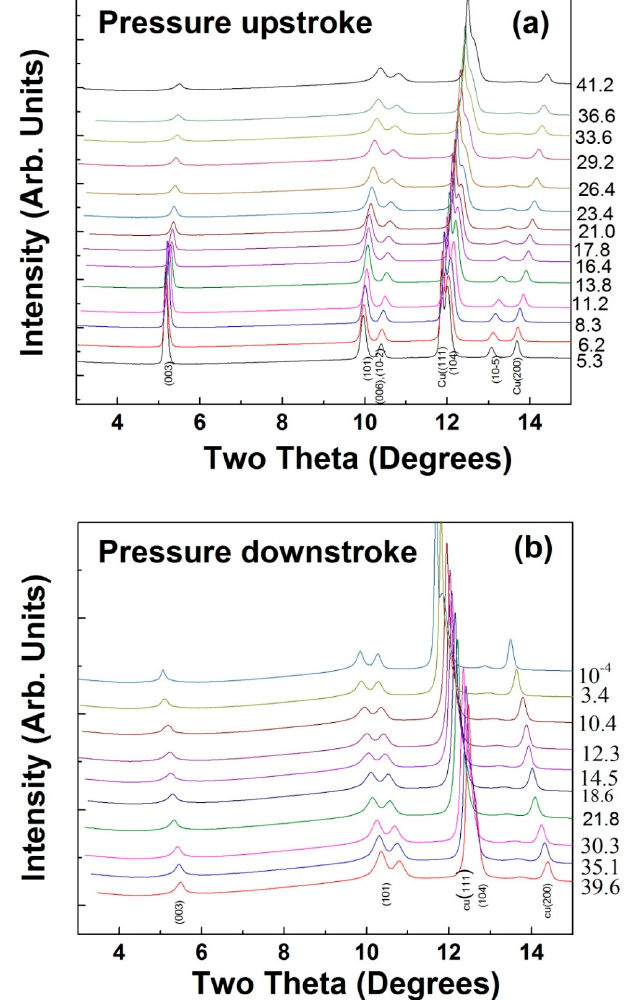
Figure 5. ( a ) Evolution of X-ray diffraction patterns for LiCrO 2 while compressing; ( b ) while decompressing. Diffraction peaks from in-situ pressure calibrant (Cu) are also indicated. Numbers on the right hand side of y-axis denote the pressure in GPa. Figure 6a–d show the representative fitted XRD patterns at 5.3, 16.4, 21.7, and 41.2 GPa, respectively.